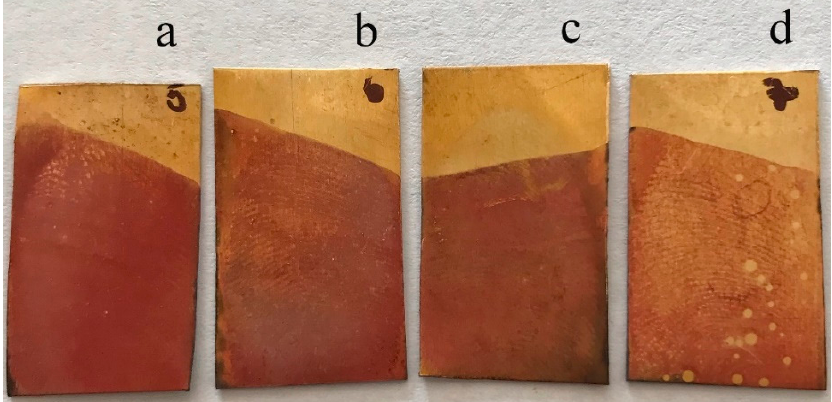
Figure 3. Optimization of the number of PNR deposition cycles for brass fingerprint visualization: ( a ) 10 cycles, ( b ) 8 cycles, ( c ) 9 cycles, and ( d ) 6 cycles.